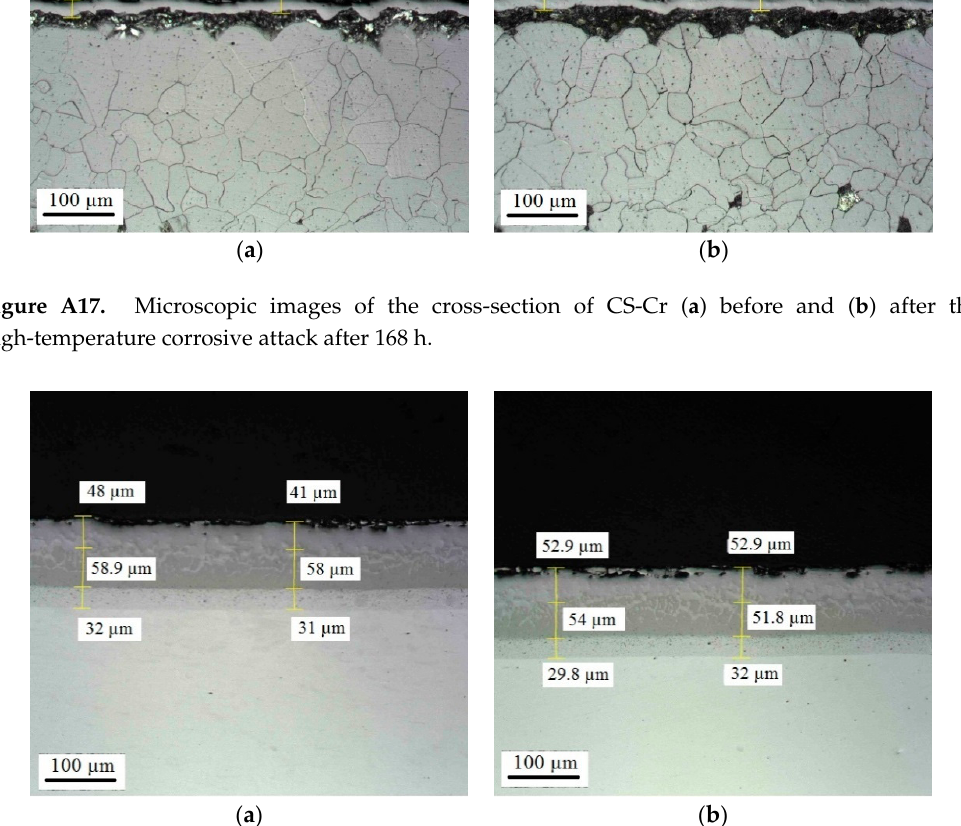
Figure A18. Microscopic images of the cross-section of 316-A ( a ) before and ( b ) after the high-temperature corrosive attack after 168 h.